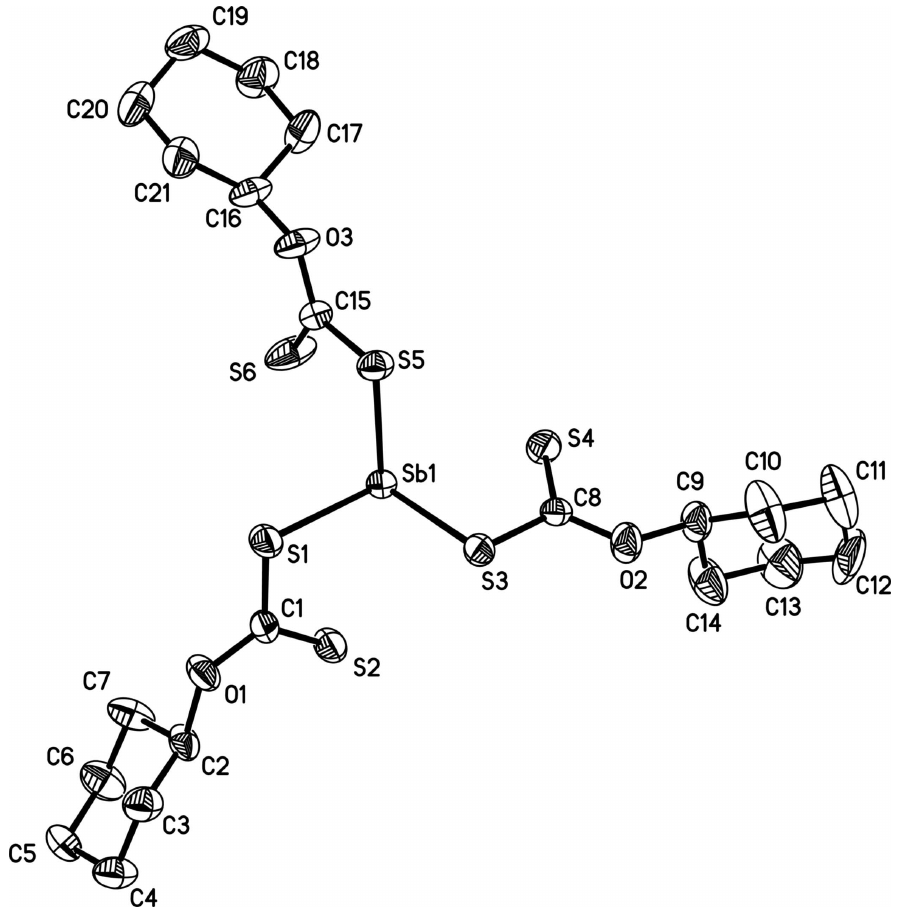
Figure 1 The molecular structure of the title compound, showing 50% probability displacement ellipsoids. H atoms are omitted for